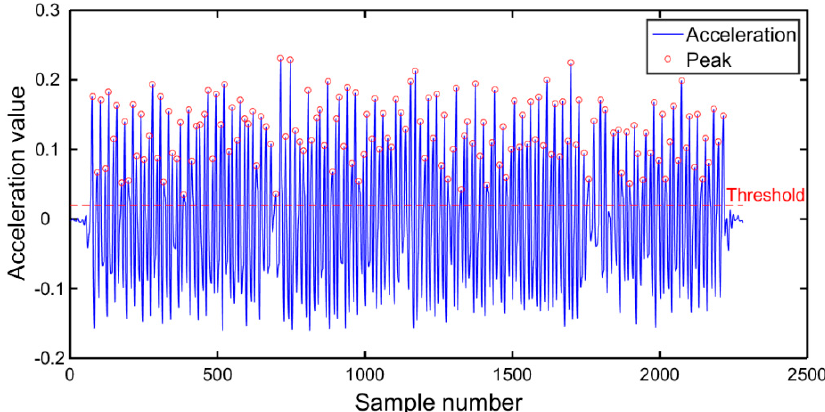
Figure 7. Peak Figure 7. Peak detection.